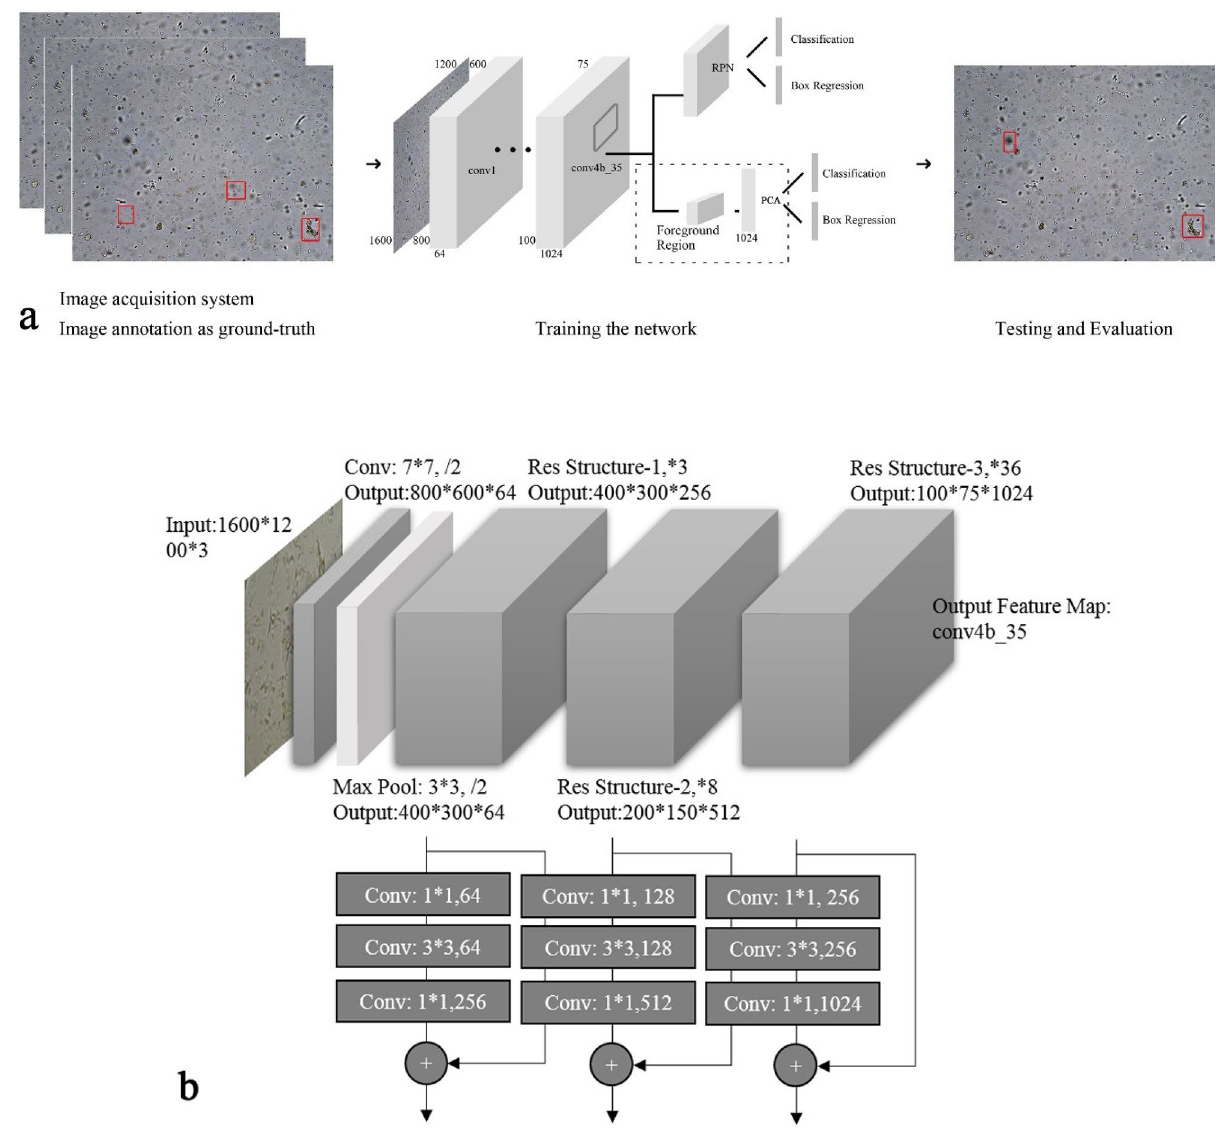
Figure 2. Overall workflow of the proposed approach and sharable 143 CNN layers of ResNet-152. ( a ) Image acquisition system. ( b ) Output feature map. Drawn by